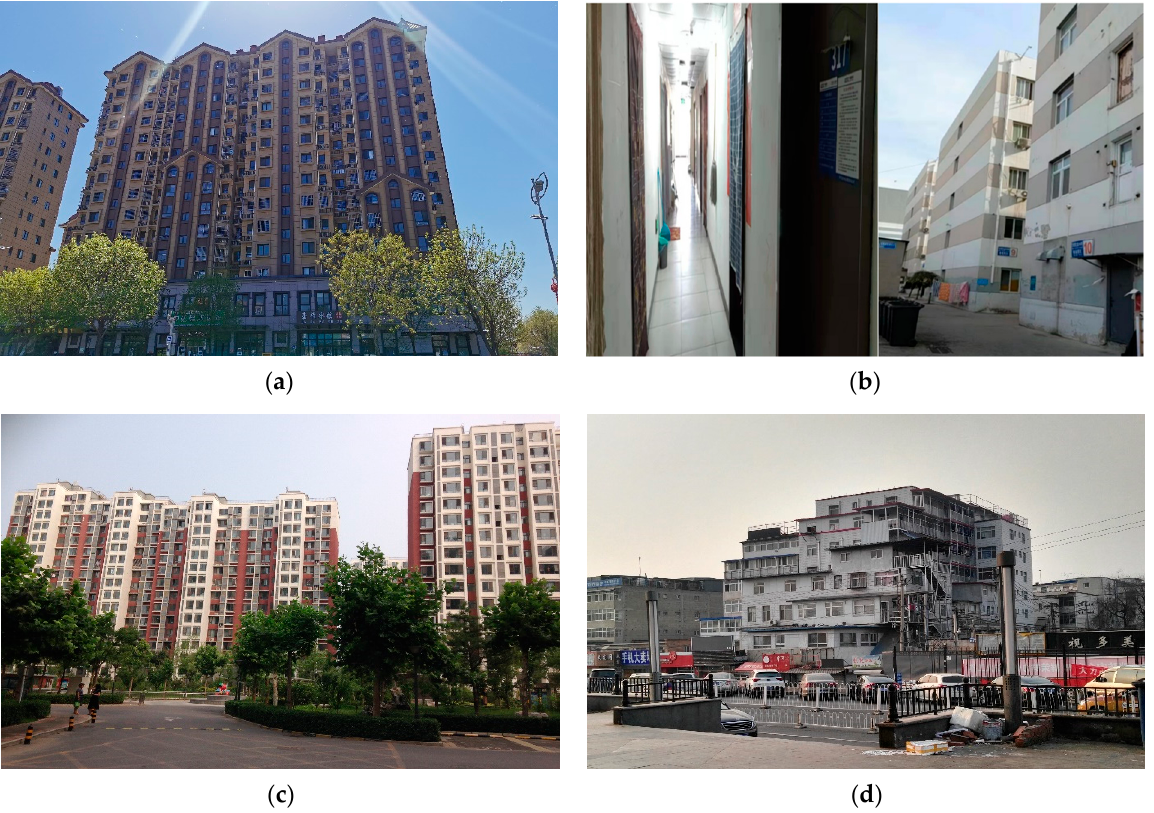
Figure 1. Housing tenure types accessible for migrants in the Beijing metropolis in China ( a ) commercial housing for self-owning or renting; ( b ) dormitory provided by employers in the industrial park; ( c ) public rented housing prepared for talented migrant workers; ( d ) “urban village” housing. Photos were taken by authors.